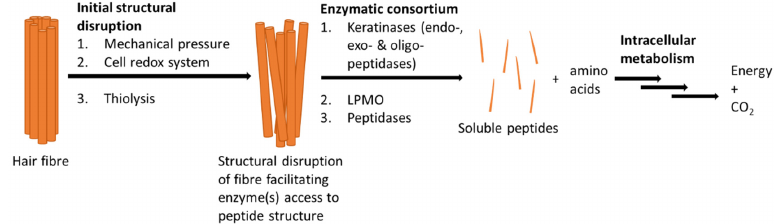
Figure 2. Possible mechanisms for microbial degradation of keratin (LPMO = lytic polysaccharide